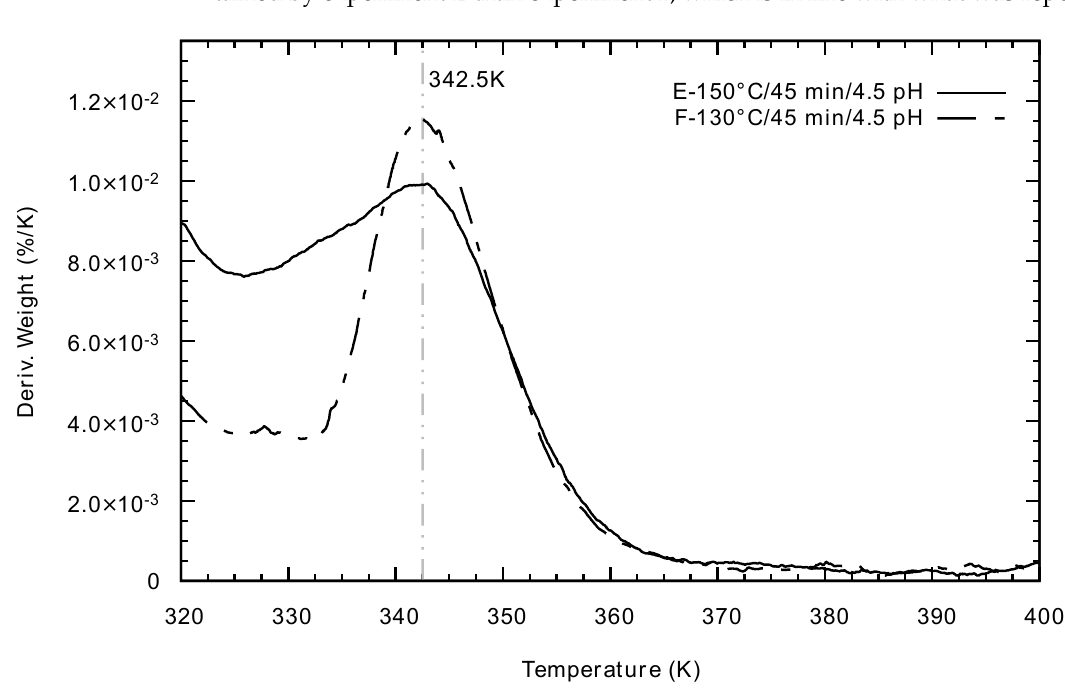
Figure 10. Differential thermogravimetric analysis for experiments E and F. This change in intensity is an indication that there are fewer Weiss domains in the perovskite obtained by experiment E than experiment F.